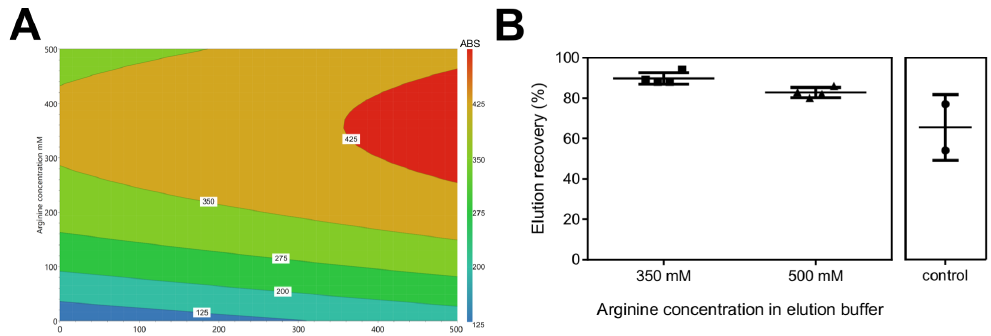
Figure 2. Optimization of elution buffer. ( A ) Response contour plot (UV 280 of eluate pools); experi- mental matrix and summary of fit are reported in Supplementary Table S1 and Figure S1,